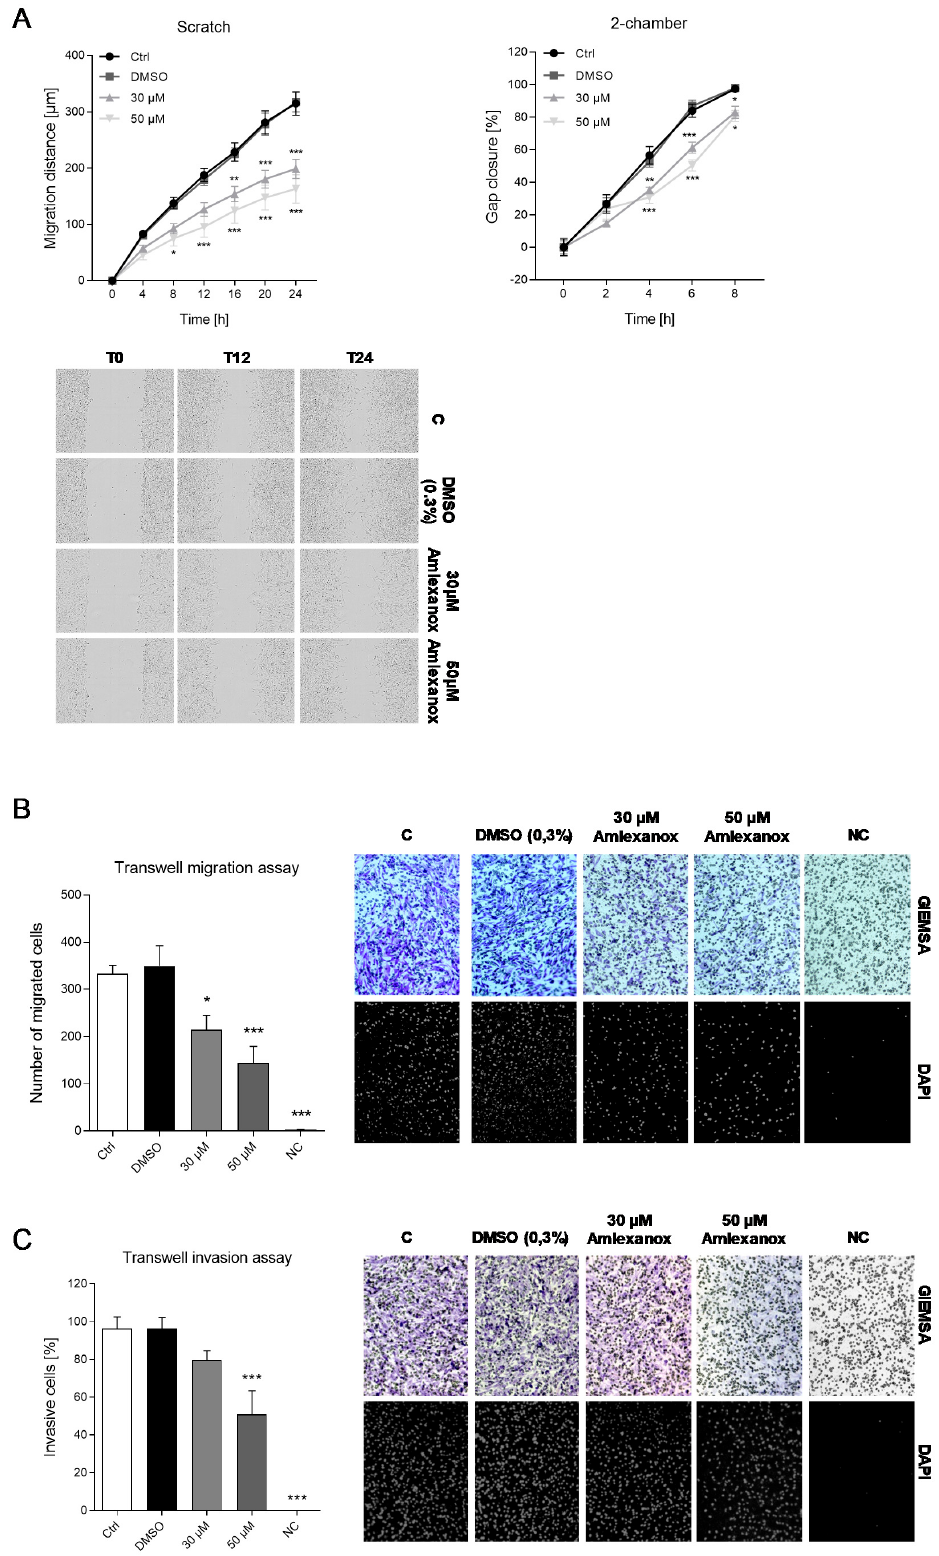
Figure 5. Migration and invasion of SK-Mel-28 cells after amlexanox treatment. ( A ) Scratch and 2-chamber migration assays were used to determine the migration distance of SK-Mel-28 cells in a time-dependent manner. Cells were treated with amlexanox at the indicated concentrations after performing a defined scratch or removing the 2-chamber insert. The images show representative